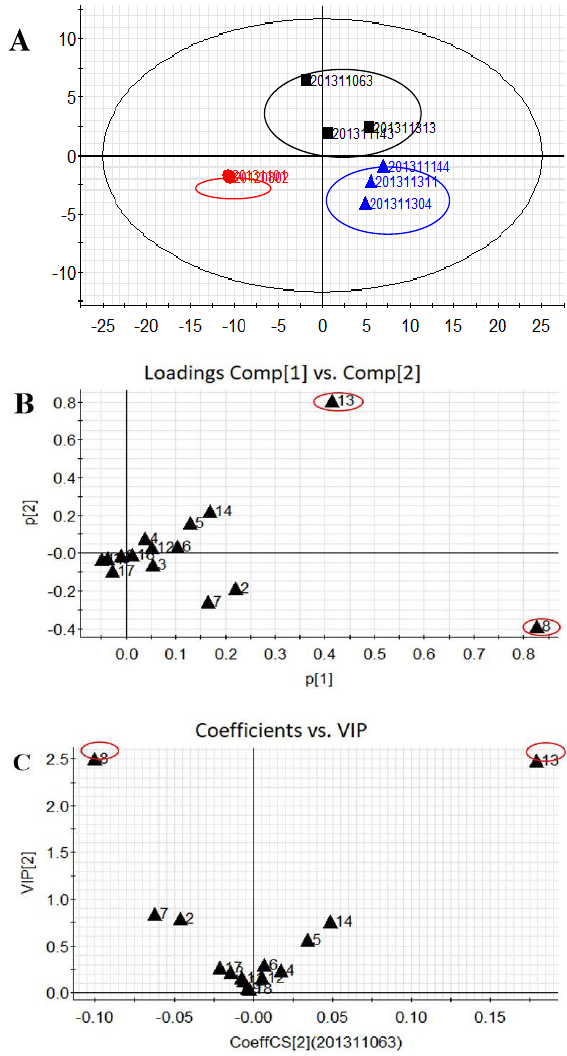
Figure 4. Principal component analysis (PCA) score plot ( A ), PCA loading plot ( B ), and VIP score plot from partial least square discriminant analysis (PLS-DA) ( C ).